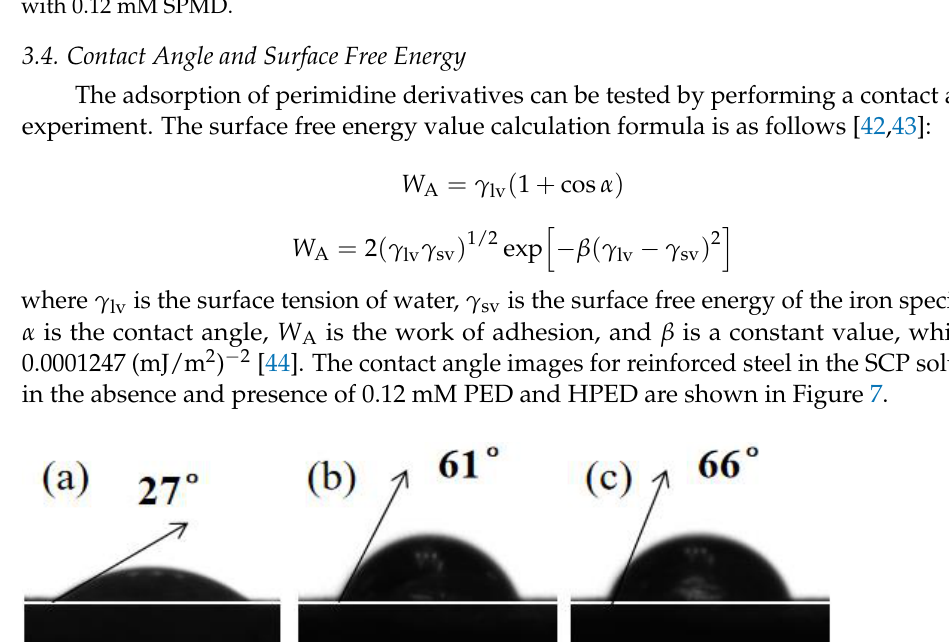
Figure 6. SEM of the specimen after submersion in SCP solution with inhibitors. ( a ) Clean speci- men; ( b ) reinforced steel in SCP; ( c ) reinforced steel in SCP with 0.12 mM PMD; ( d ) reinforced steel in SCP with 0.12 mM SPMD.